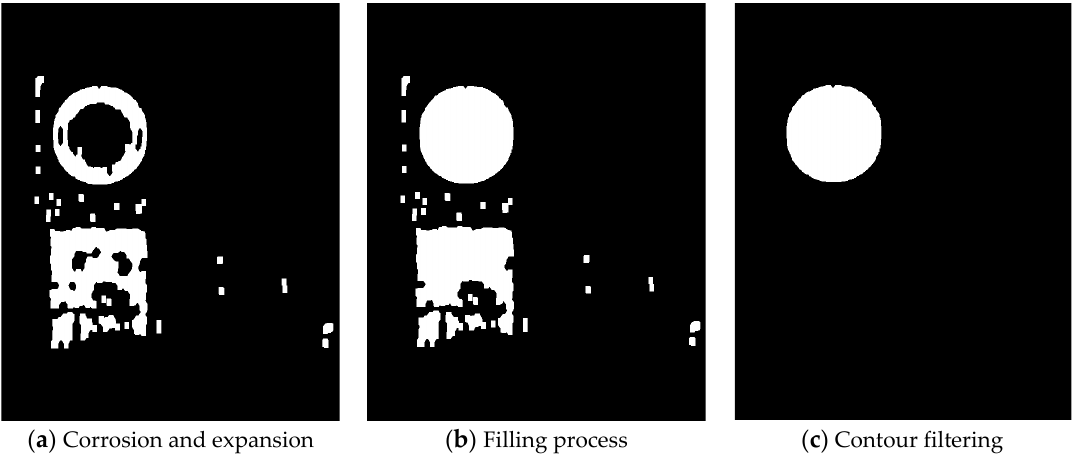
Figure 5. The morphological processing for binary images.